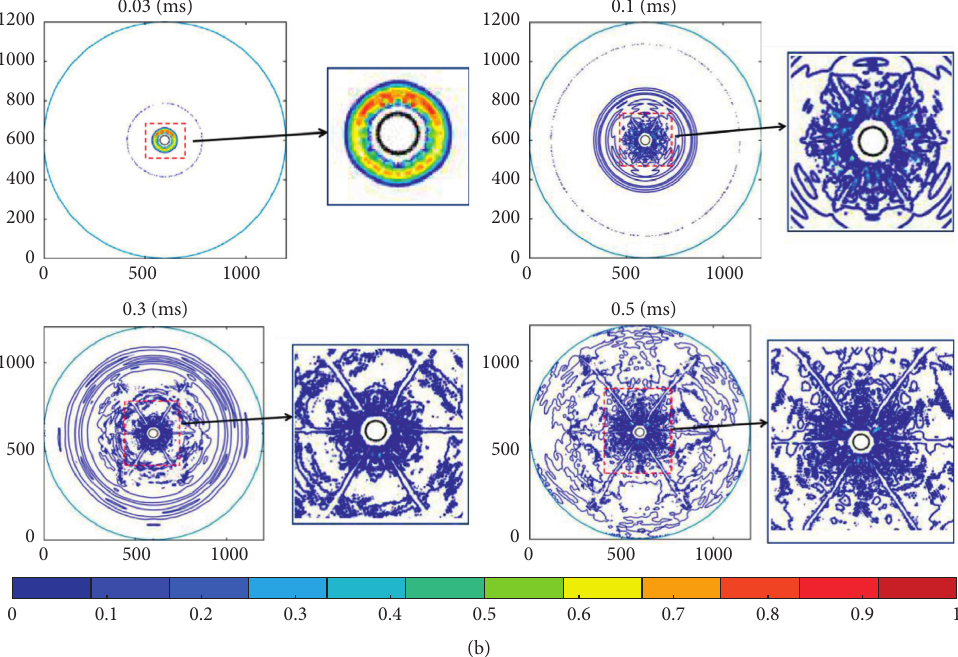
Figure 6: Damage evaluation and effective stress evaluation for single hole concentrated energy blasting. (a) Development of common blasting damage. (b) Development process of equivalent stress in ordinary